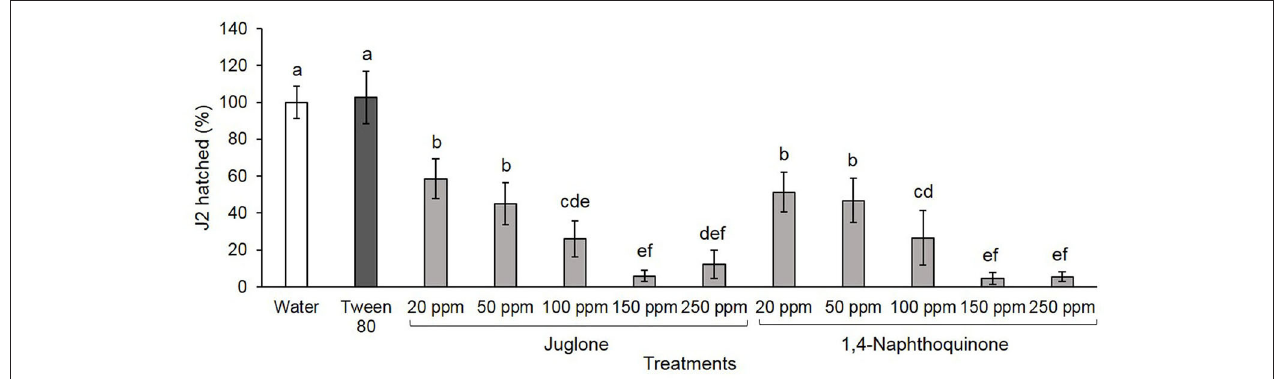
FIGURE 2 | Meloidogyne luci second-stage juveniles (J2; %) hatched for 15 days. Eggs were soaked in water, 2,500 ppm Tween ® 80 solution, and juglone and 1,4-naphthoquinone at different concentrations. Each bar represents the average ± standard deviation of four replicates and bars denoted by different letters differ significantly at p > 0.05, according to the Fisher’s LSD test.